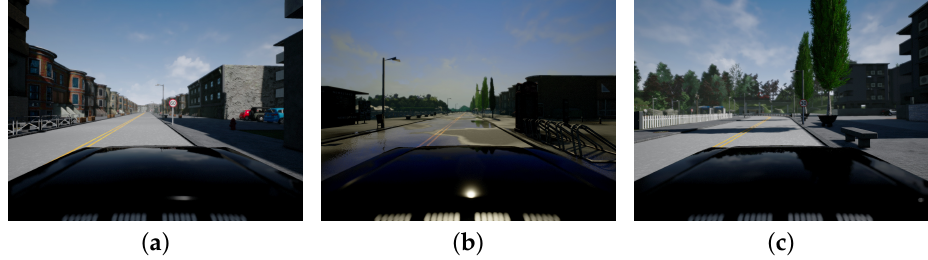
Figure 4. Examples of photo-realistic environments in the CARLA simulator. ( a – c ) show the capture of some different panoramas and shades in the CARLA simulator.